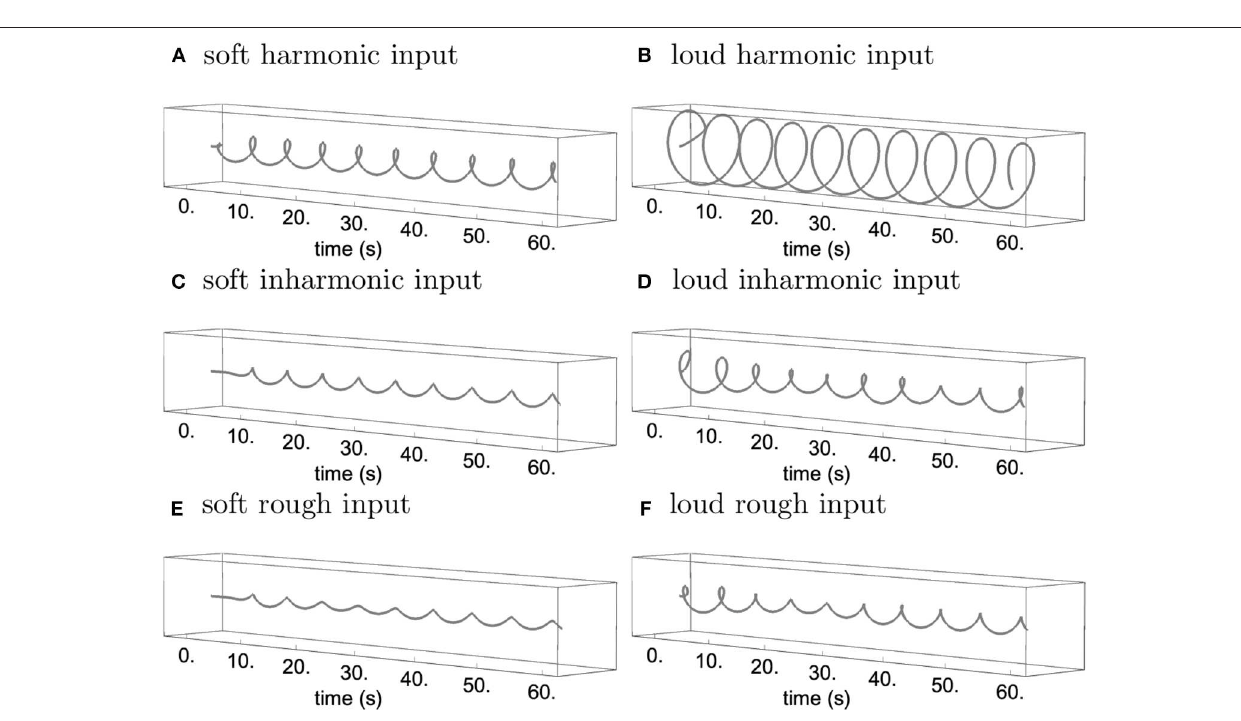
Frontiers in Applied Mathematics and Statistics | www.frontiersin.org